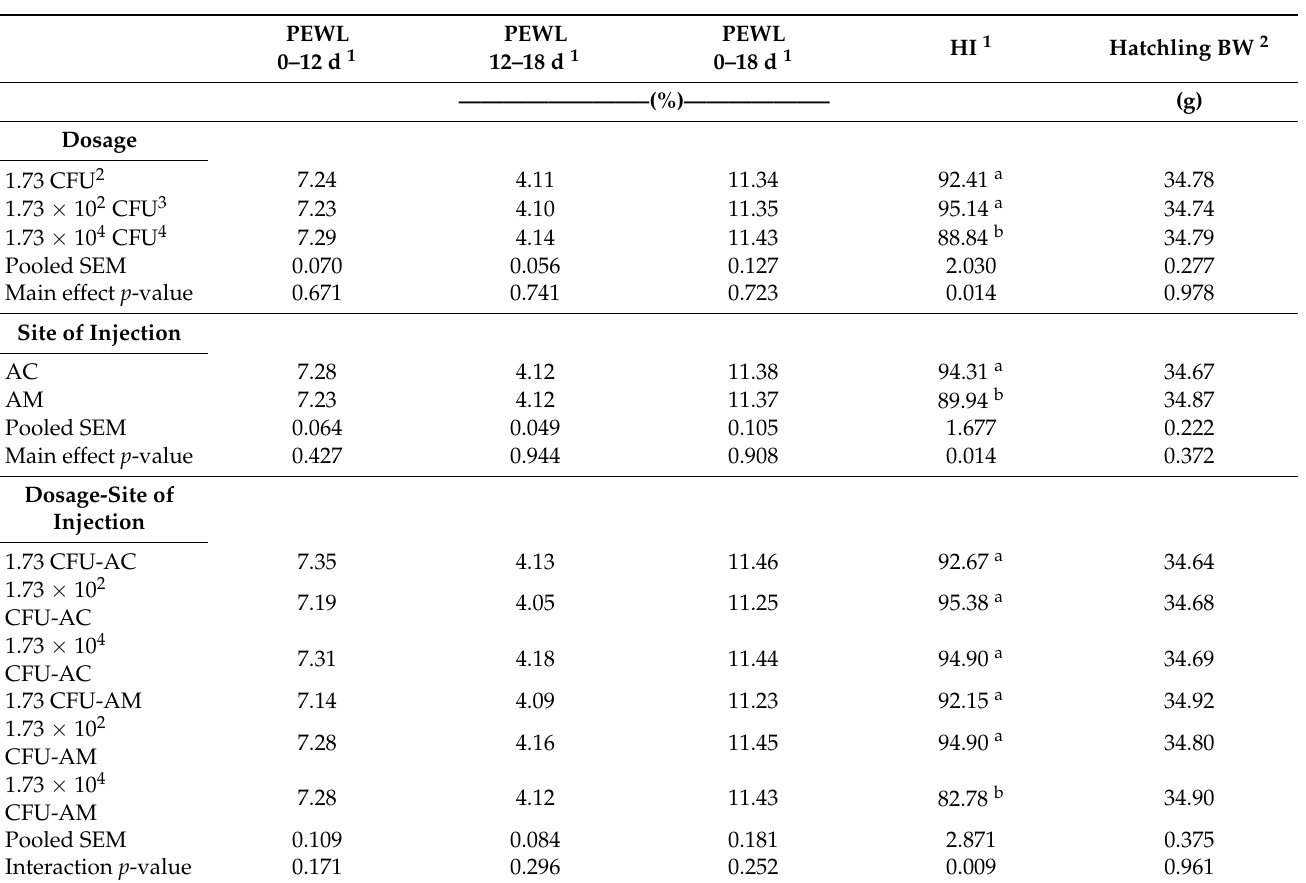
Table 5. Main and interaction means of percentage egg weight loss ( PEWL ) between 0 and 12, 12 and 18, and 0 and 18 days ( d ) of incubation ( doi ) and hatchability of injected eggs containing viable embryos ( HI ) and mean hatchling BW determined at pull time (22 doi) due to 6/85 MG dosage